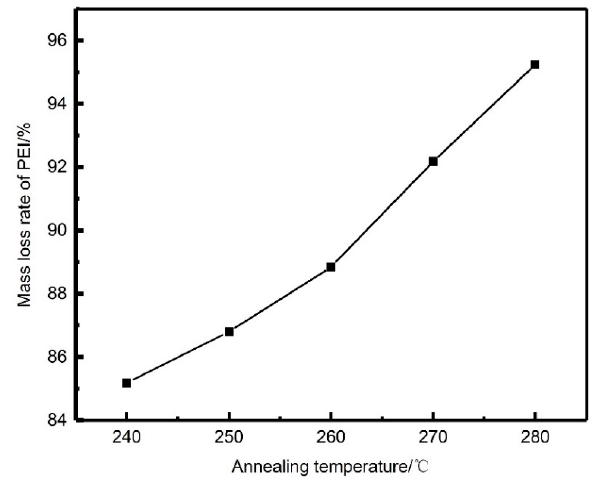
Figure 4. Mass loss rate of PEI after extraction of each annealing sample.